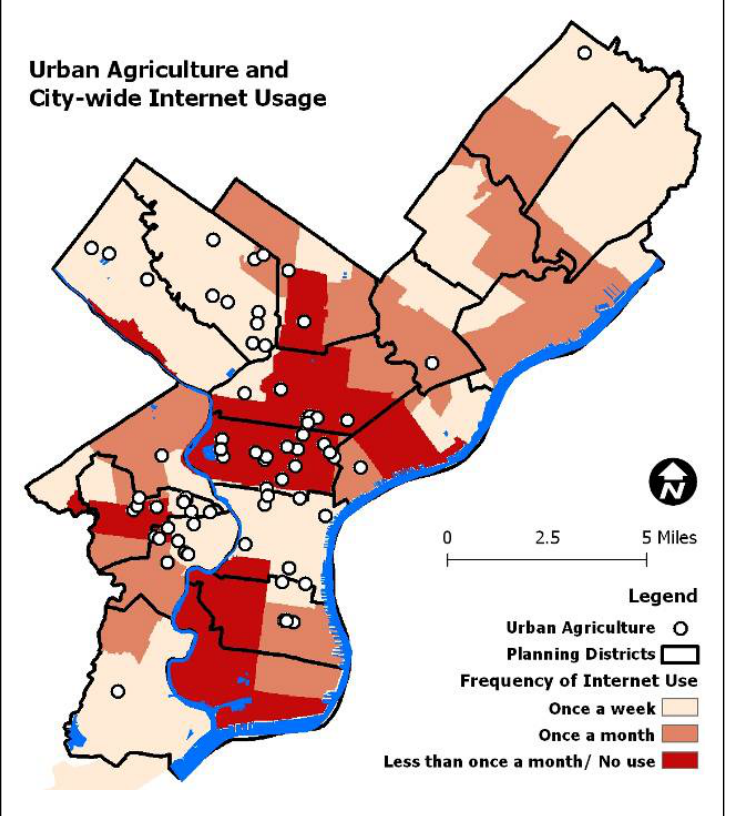
Figure 4. Spatial Pattern of Internet Use and UA Project